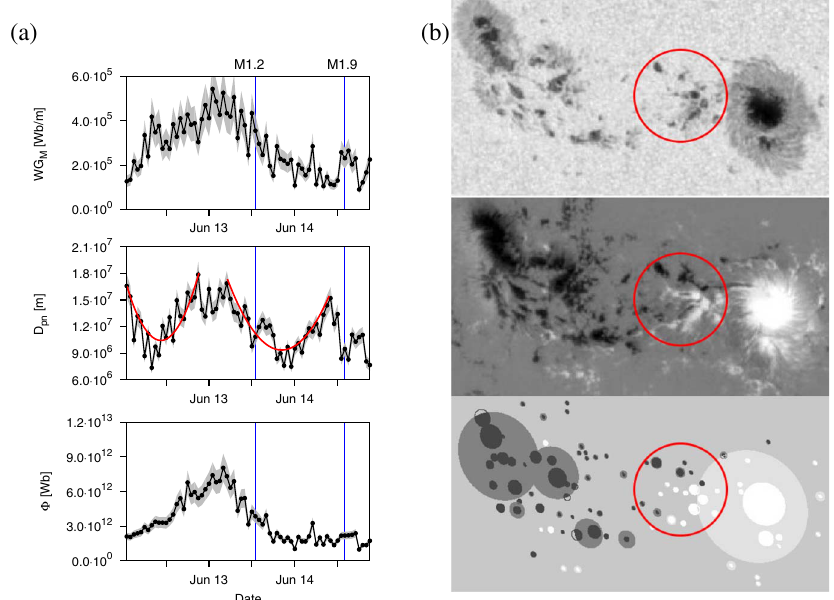
Fig. 1. (a) Example for applying the WG M method to two smaller (M1.2 and M1.9) GOES M-class fl ares in AR 11504. The top panel shows the WG M , the middle panel plots the distance between the barycentres, and the bottom panel is a plot of the associated unsigned magnetic fl ux as a function of time. The M1.2 and M1.9 fl ares are indicated by (blue) vertical lines where the value of the WG flare (red parabolae) in the middle panel that are key fl are precursors of the WG M method. The error is marked with shaded grey. (b) Top/middle and bottom panels are the related intensity/magnetogram maps and the associated Debrecen data catalogue representation of synthetic polarity drawing of AR at 01:59 on 13 June 2012. The red circle shows which umbral area and mean fi eld strength are taken to calculate WG M .